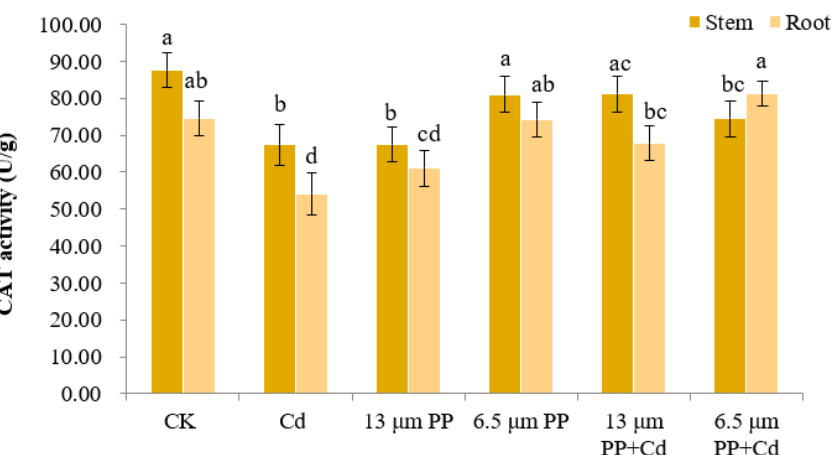
Figure 4. Effect of PP MPs and Cd on catalase activity (CAT) of rice seedlings. Results are shown in mean ± SD ( n = 9). Different lowercase letters a, b, c and d represent significant difference between different treatments groups at the same MP particle size or at the same cadmium concentration (at p ≤ 0.05), whereas the same letters indicate insignificant differences between treatments. Where CK—Control check; Cd—Cadmium; PP—Polypropylene.